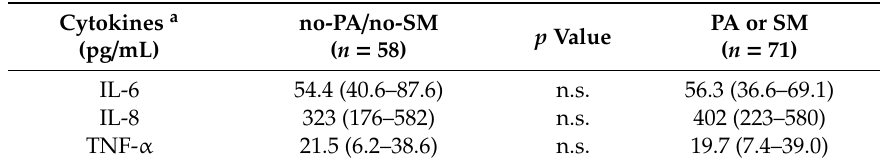
Table 6. Salivary IL-6, IL-8, and TNF- α levels in CF patients with P. aeruginosa (PA) or S. maltophilia (SM) and without PA / SM